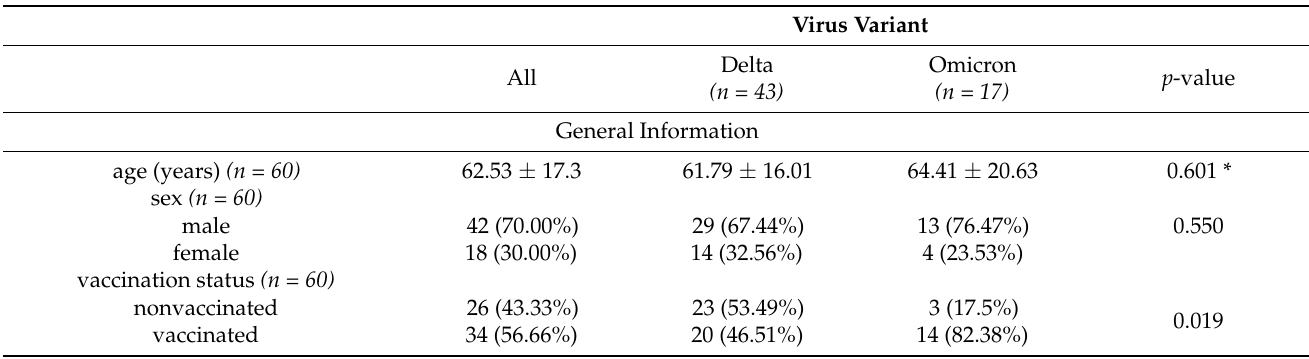
Table 1. Patients’ demographic and clinical parameters according to virus